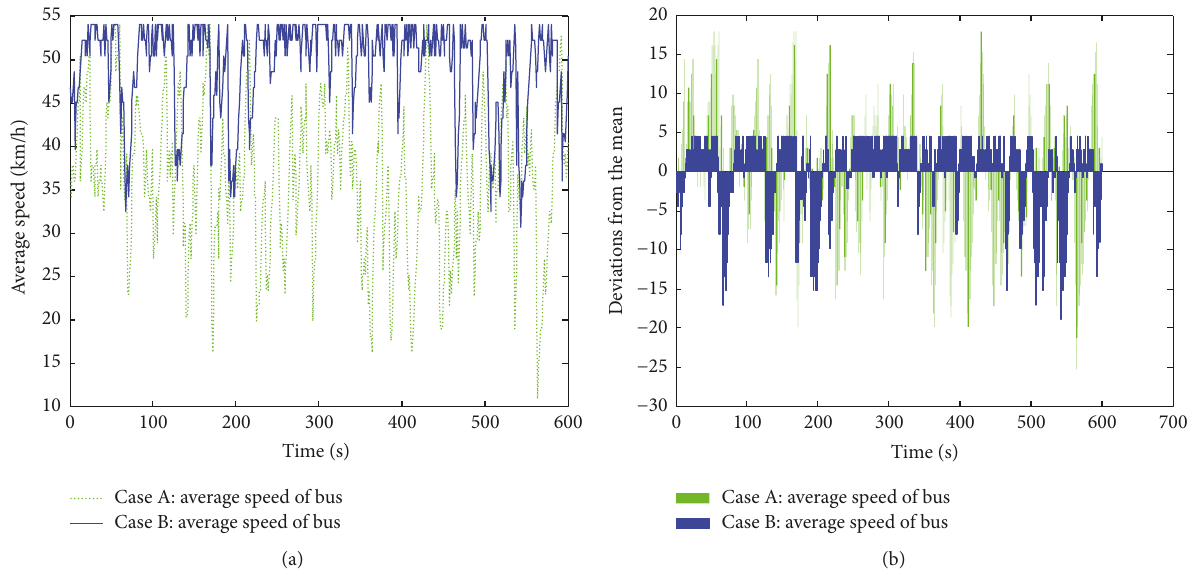
Figure 4: Average speed distributions of Case A and Case B. (a) Average bus speed in Case A and Case B. (b) Deviations from the mean of average bus speed in Case A and Case B.